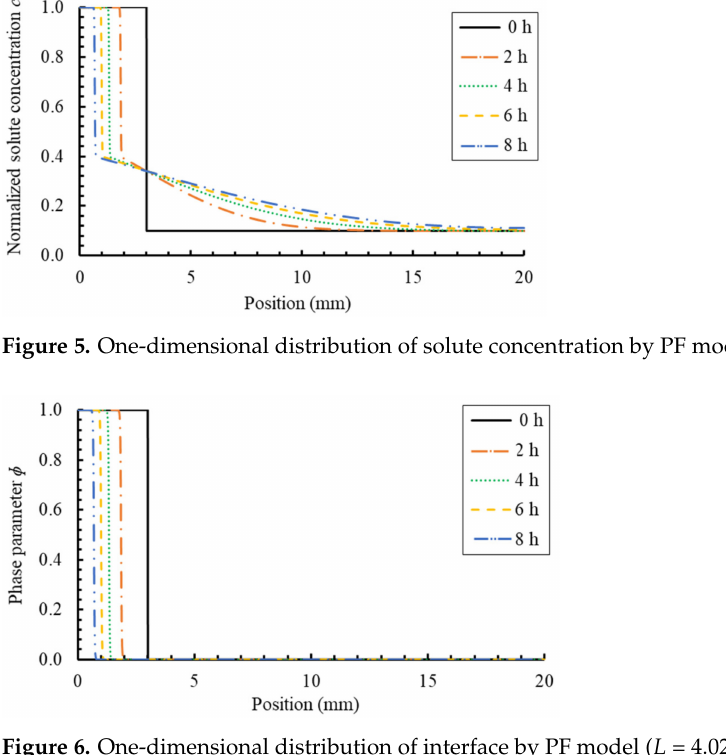
Figure 6. One-dimensional distribution of interface by PF model ( L = 4.02 × 10 − 1